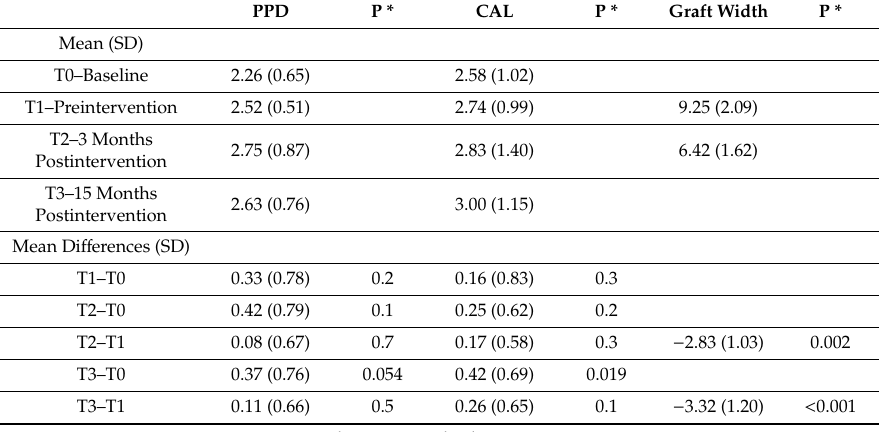
Table 3. Probing pocket depth (PPD), clinical attachment level (CAL), and graft width evolution. PPD P